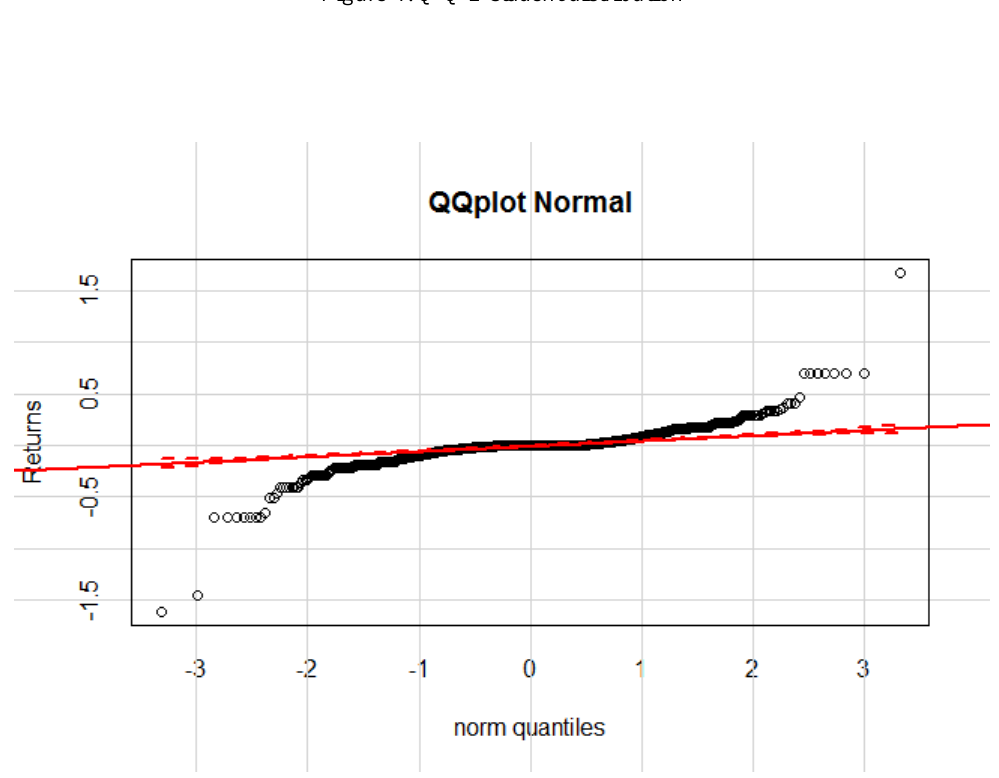
Figure 4. Q-Q 2-student distribution